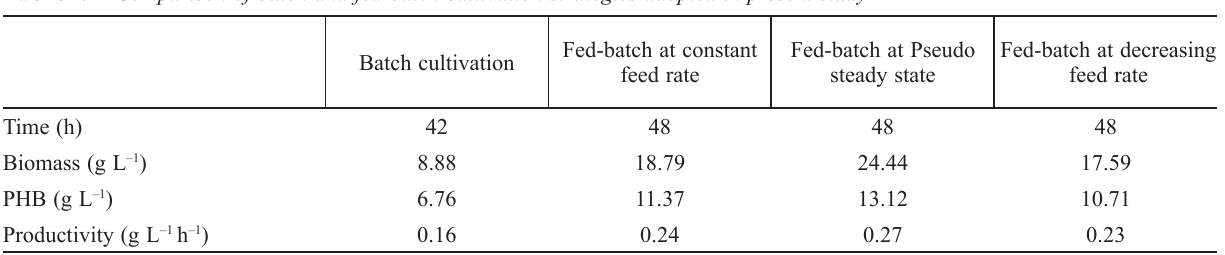
Table 8 – Model predictions and experimental data of fed-batch cultivation of C. necator Cultivation strategy